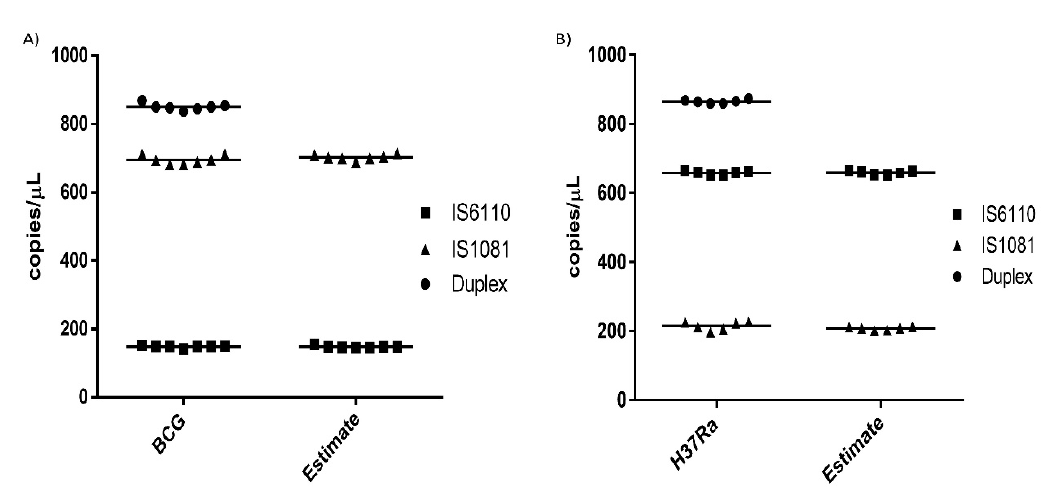
Figure 7. Reproducibility of replicate wells. ( A ) M. bovis BCG reproducibility results with BCG showing